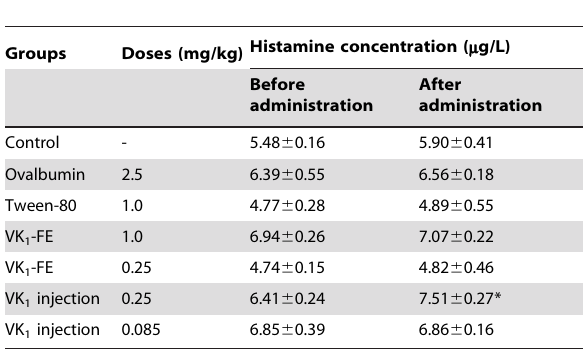
Table 3. The change in plasma histamine concentrations after the first intravenous administration.